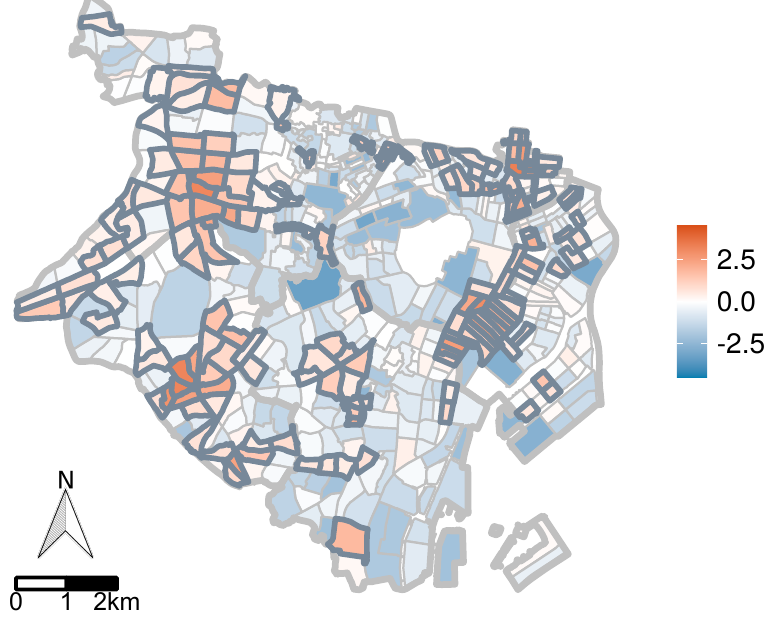
Figure 6. Estimated subregion-based coefficients. Subregions bounded by bold lines are detected as constituting